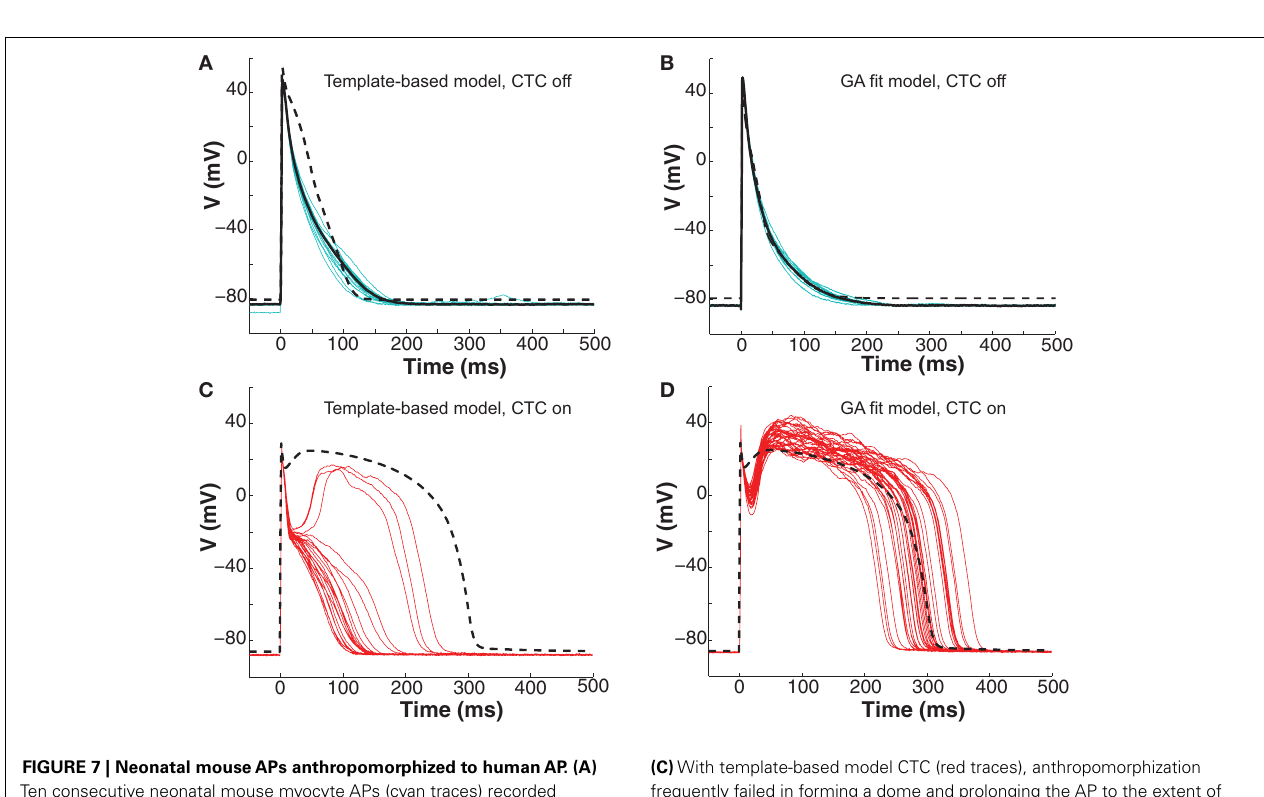
template-based model usage. (C) AP duration at different repolarization levels for template-based model CTC vs. GA-fitting CTC. For all three repolarization markers, the GA-fit model CTC reproduces recipient model APD values (diamonds), while template-based model CTC produces waveforms of insufficient duration. Error bars in all panels give standard deviation, n = 10 cells.